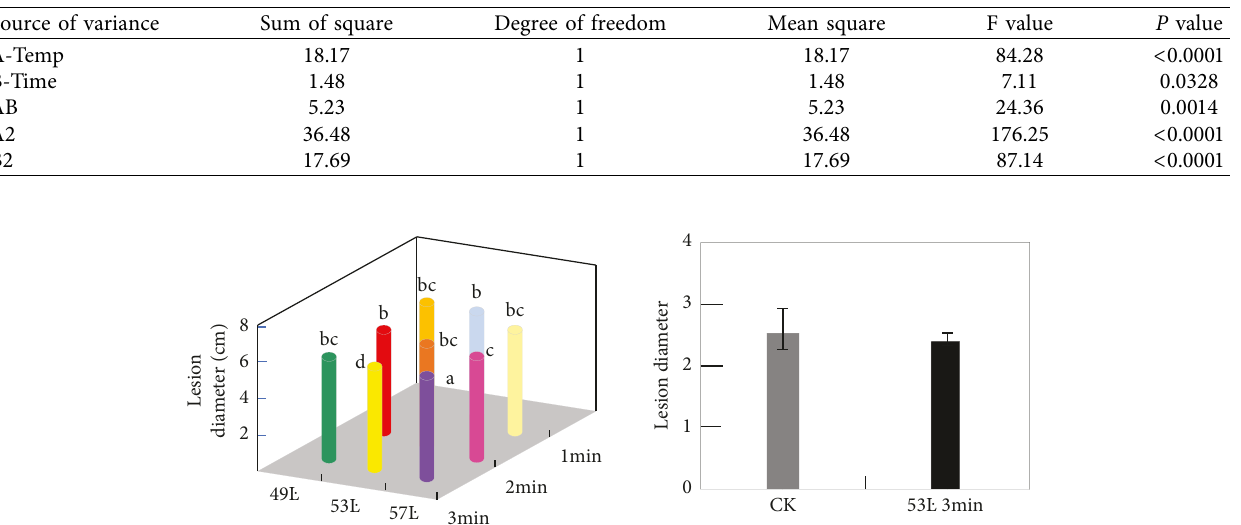
Table 5: Analysis of variance results of the regression model.